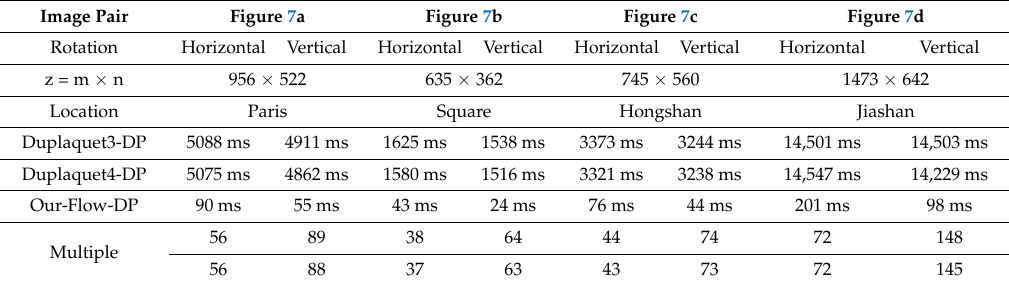
Table 1. Time efficiency comparison of energy accumulation processing with different methods Image Pair Figure 7a Figure 7b Figure 7c Figure 7d Rotation Horizontal Vertical Horizontal Vertical Horizontal Vertical Horizontal